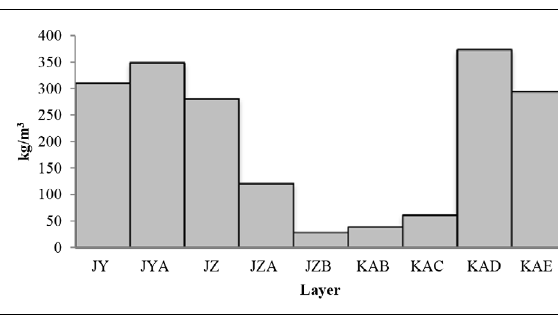
Figure 3: Density of shellfish per layer (kg/m 3 ) in Klipdrift Cave. Shellfish size Turbo sarmaticus opercula